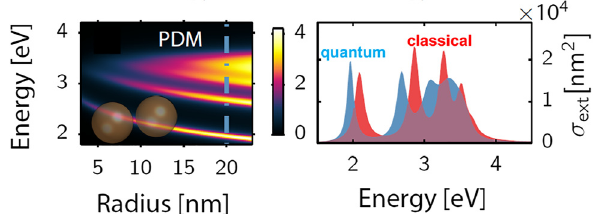
Figure 13: Extinction spectra for sodium nanosphere dimers, contrasting results from local-response approximation (LRA) (red-filled curve) and the projected-dipole model (blue-filled curve). Despite the relatively large radius R of the spheres, being far too large to promote significant size corrections to the LRA, the tiny gap g = 0 . 74 nm is in itself sufficient to promote significant gap-dependent corrections. Figure reproduced from Ref. [202] ( © 2015 American Physical